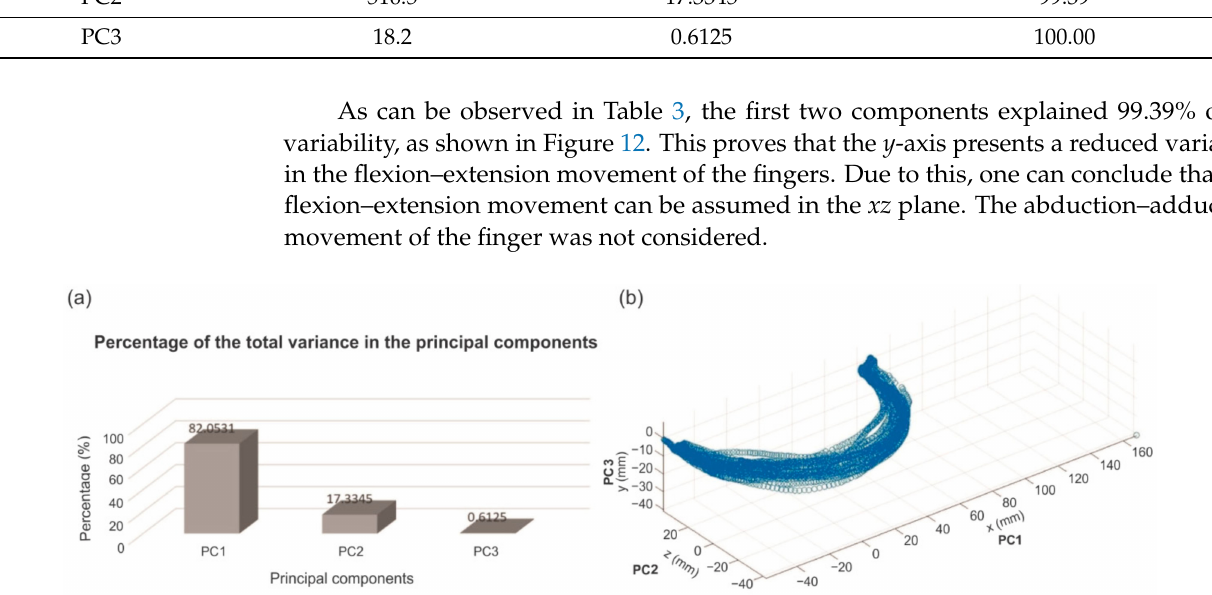
Figure 12. Principal components representation. ( a ) Percentage of the total variance. ( b ) The data represented in the space of the three principal components.